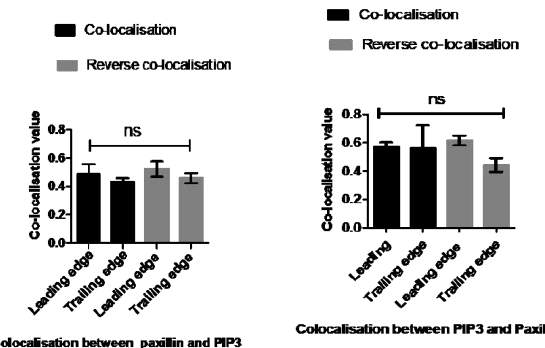
Figure 3 : Quantification of spatial co-localisation between PtdIns(3,4,5)P3and paxillin at the leading and trailing edges. Spearman’s (rho) correlation coefficient analysis was used to measure co-localisation value between PtdIns(3,4,5)P3and paxillin at the leading and trailing edges A) On fibronectin: Co-localisation and Reverse co-localisation values between PtdIns(3,4,5)P3and paxillin were moderate co-localisation. B) On collagen: Co-localisation and Reverse co-localisation values between PtdIns(3,4,5)P3and paxillin were moderate co-localisation. Statistical analysis was performed by One- way ANOVA with Tukey's Multiple Comparison Test, non- significant difference between co-localisation values at P≤0.05.Data are a representative of the means±SD of three independent experiments in which n=10 cells were measured, and number of a single FA=10 for each